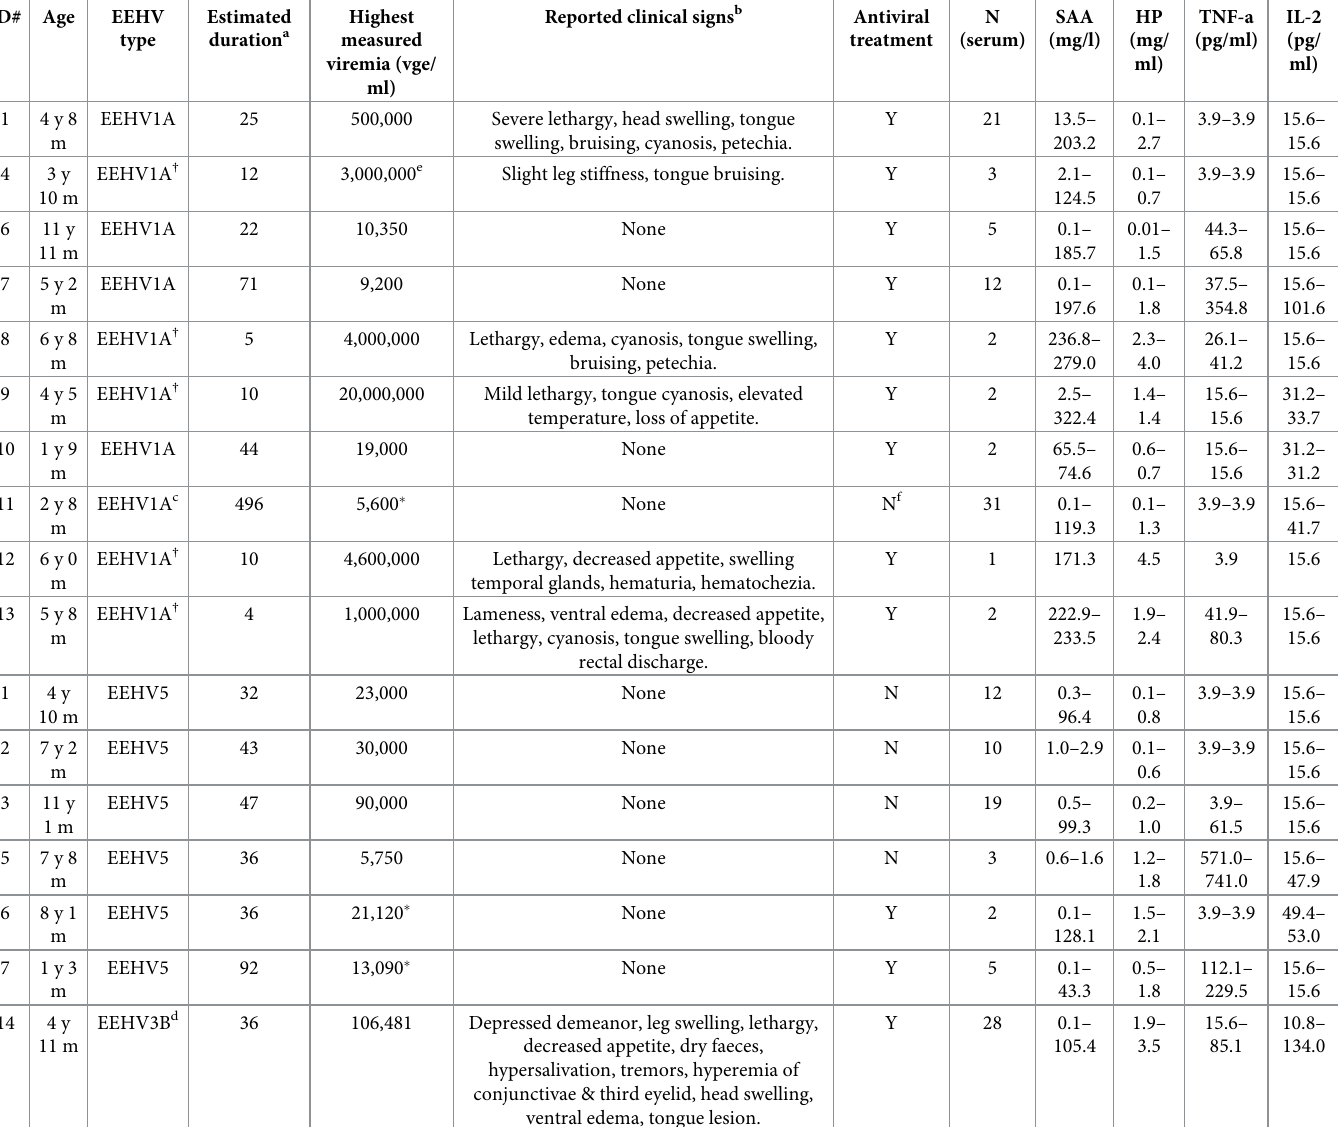
Table 2. Range (minimum-maximum) of serum biomarker concentrations during cases of viremia exceeding 5000 vge/ml whole blood in 1 African and 13 Asian